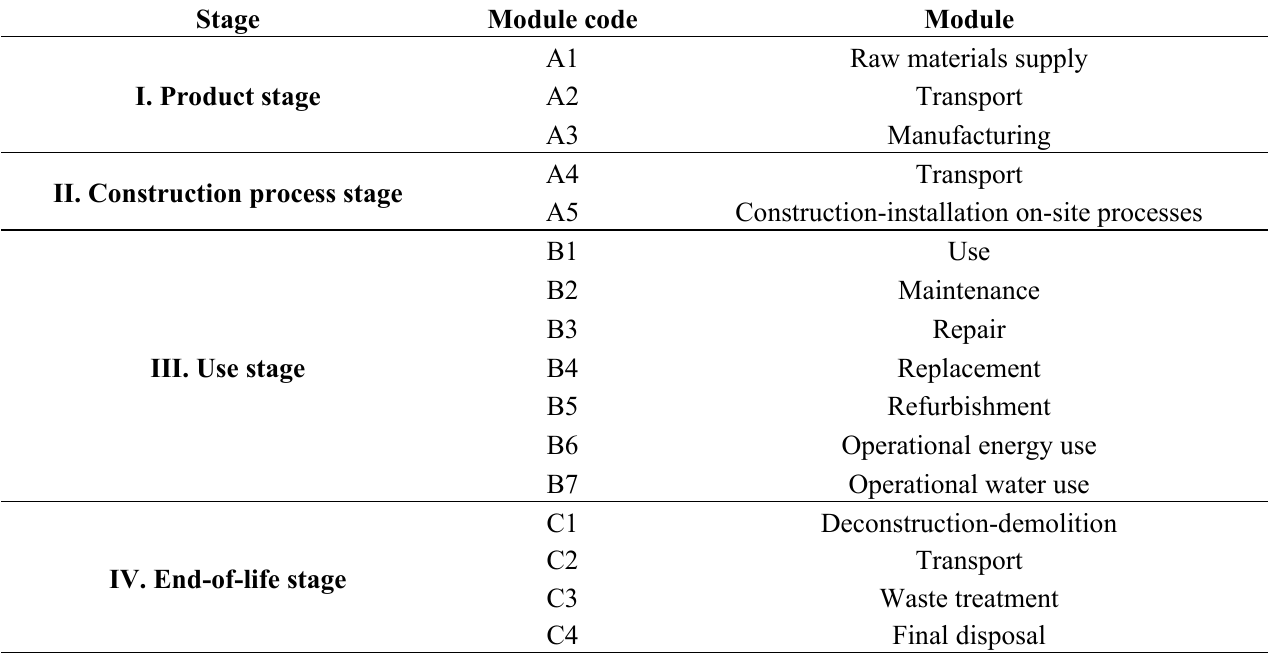
Table 1. Life cycle stages of a building based on the CEN/TC 350 standard, EN 15643-2 Sustainability category